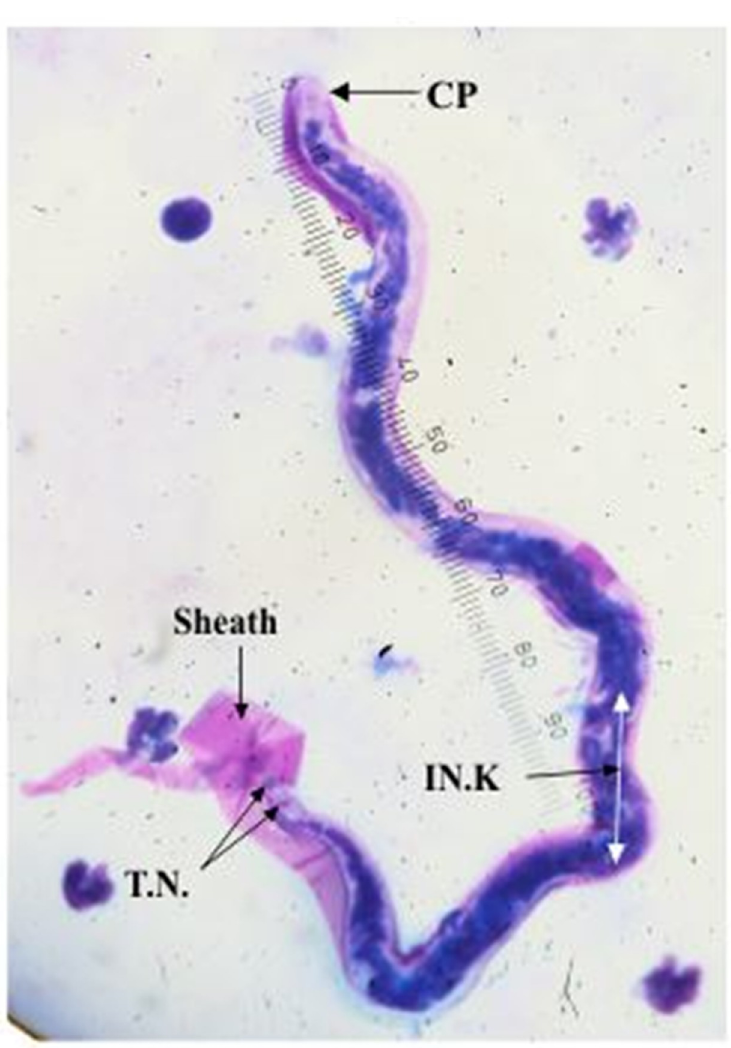
Fig 1. Microfilaria of B . malayi . CP- Cephalic space IN.K.- Innen-korper T.N.- Terminal